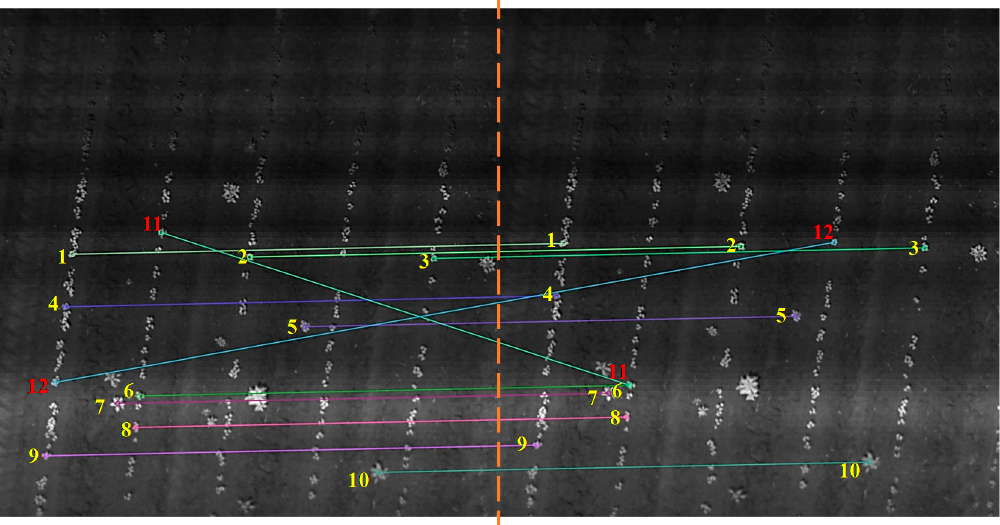
Figure 4. Illustration of identification of false matches using the slope and length of matching lines that connected every two key points in two successive images. The slopes and the lengths of all lines of the yellow matches were similar (parallel lines). However, the lines of two false matches (the red matches of No. 11 and 12) had obviously steeper slopes and longer or shorter lengths than the rest of the matching lines.